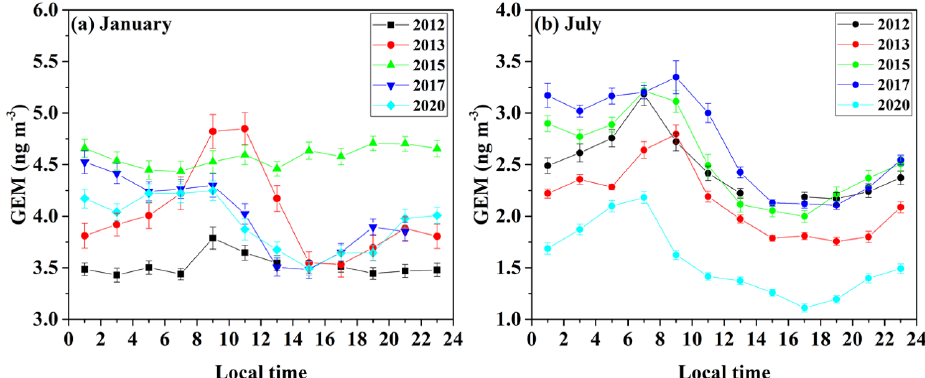
Figure 3. The diurnal trend of GEM concentrations in (a) January and (b) July over the study years. Note that the value of error bars has been reduced